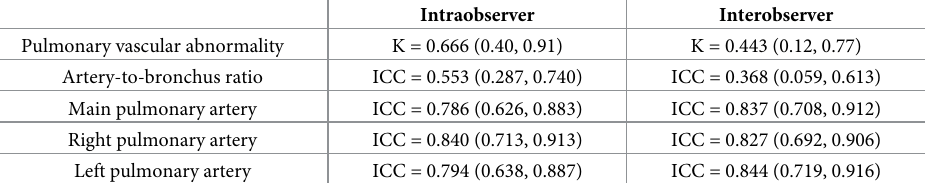
Table 3. Intraobserver and interobserver reliability of qualitative and quantitative abnormal computed tomogra- phy findings.